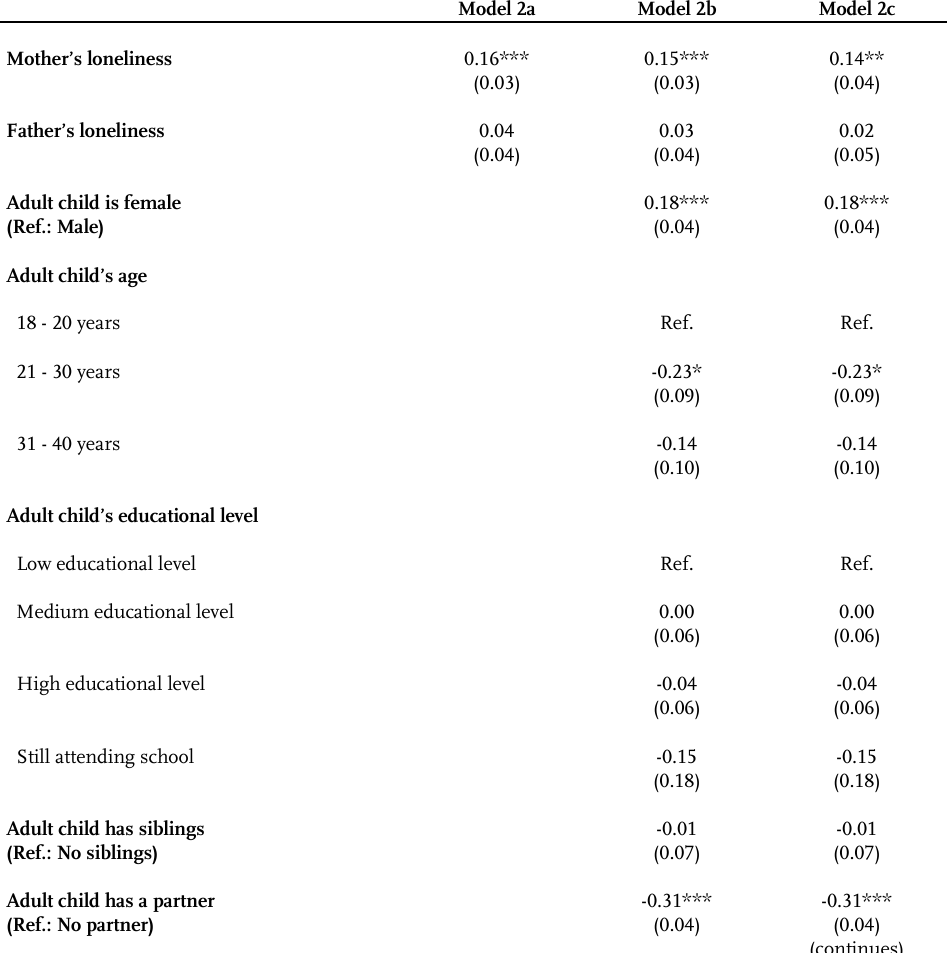
Table 4 : Multilevel regression: The relationship between loneliness in parents and their adult children living in their own household (unstandardized